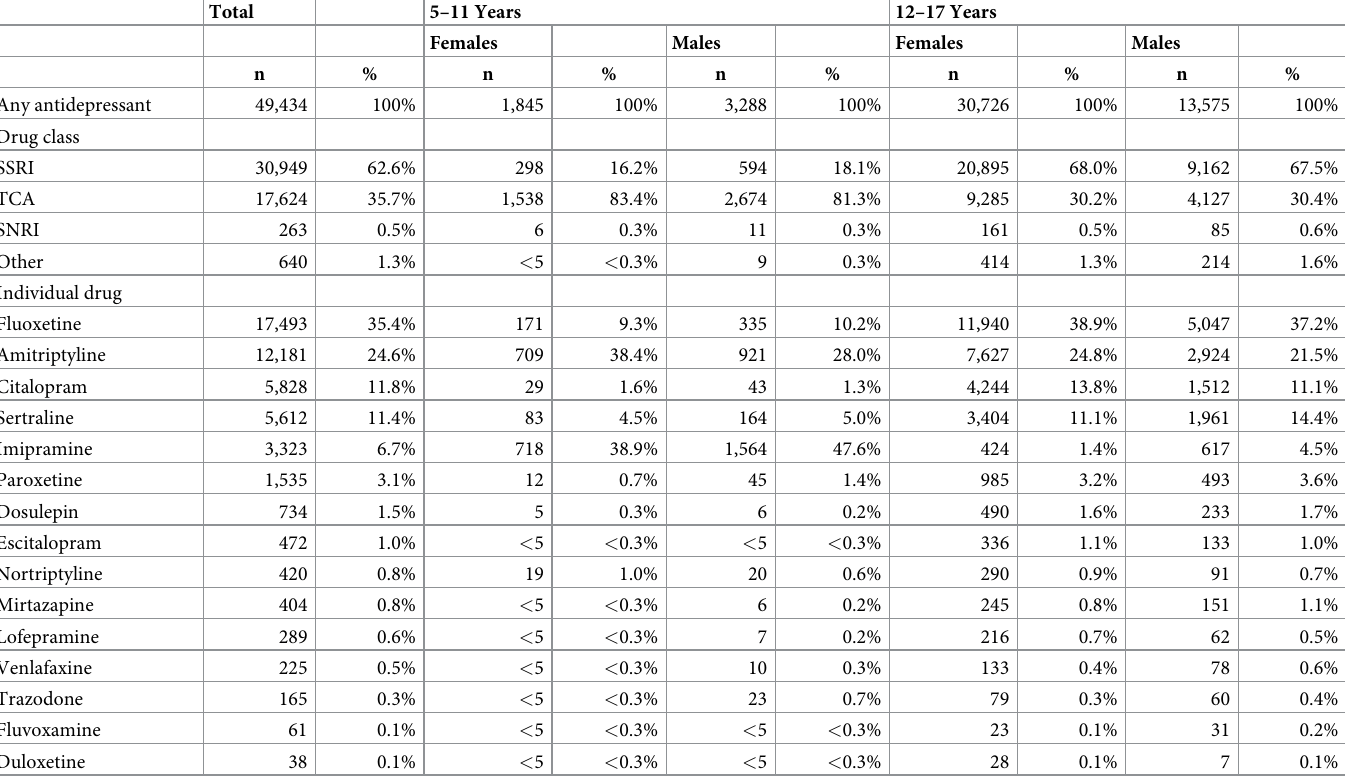
Table 2. Number and percentage of CYP with first prescriptions in each drug class and for individual drugs during the study period, England 1998–2017, by age and